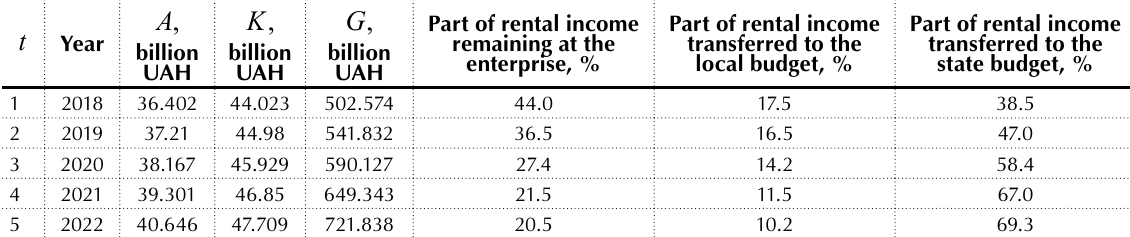
Table 2. The optimal distribution of rental income from the extraction of natural resources (values changing over